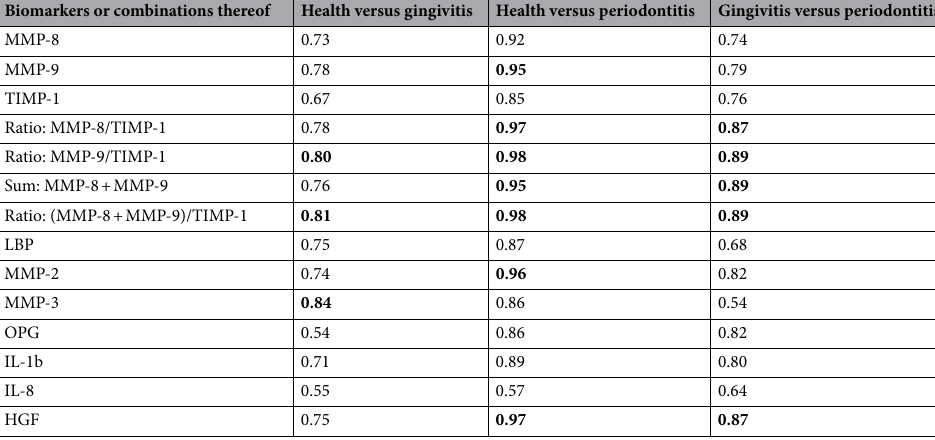
Table 4. Area Under the Curve measurements for all biomarkers and combinations thereof. The values above the thresholds are represented with bold